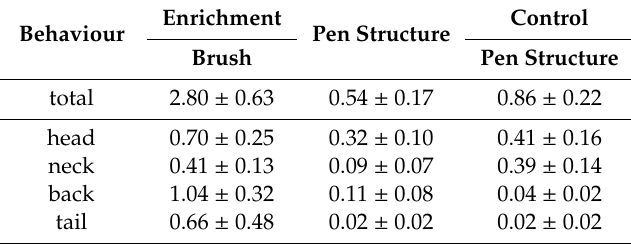
Table 2. Mean time budgets (% ± SEM) of scratching cattle’s body on brush or pen structures in enrichment and control animals in Trial 1.